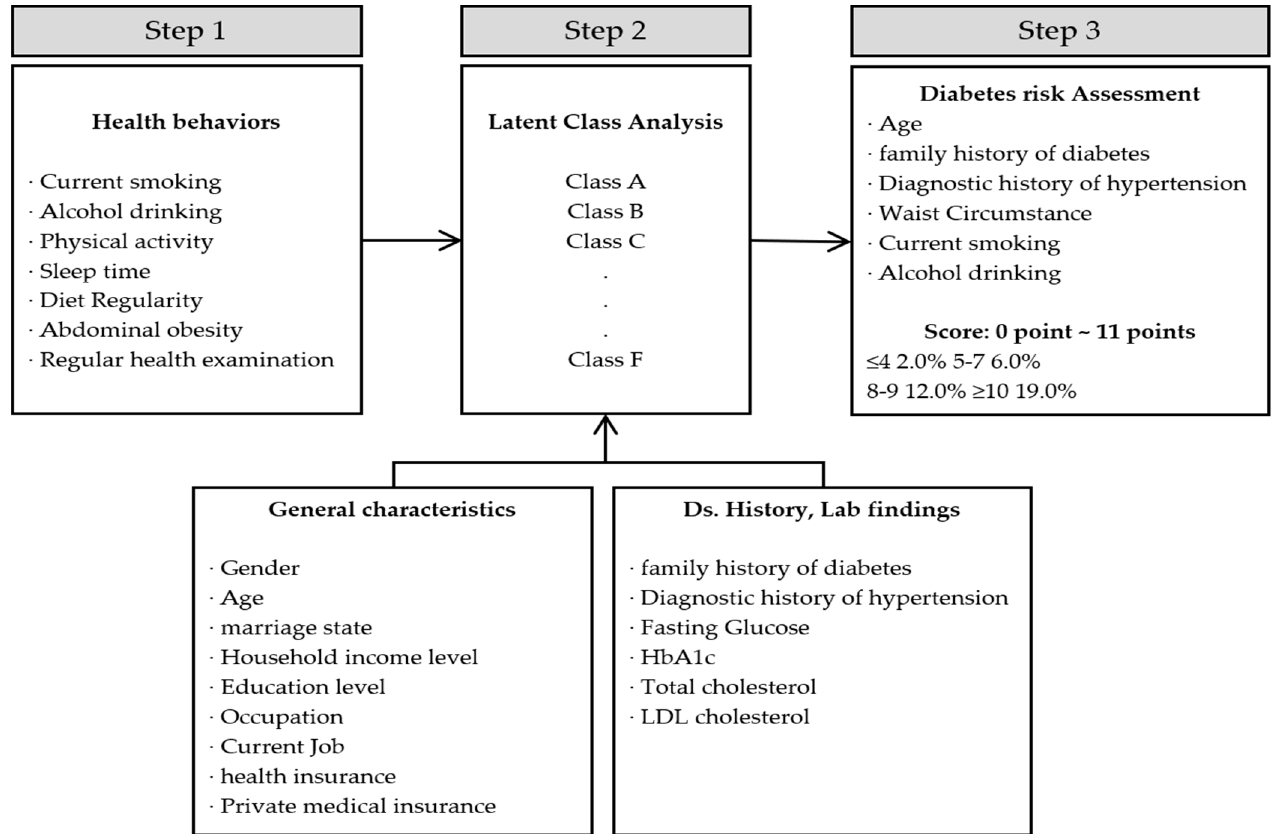
Figure 1. Flowchart of the study process.